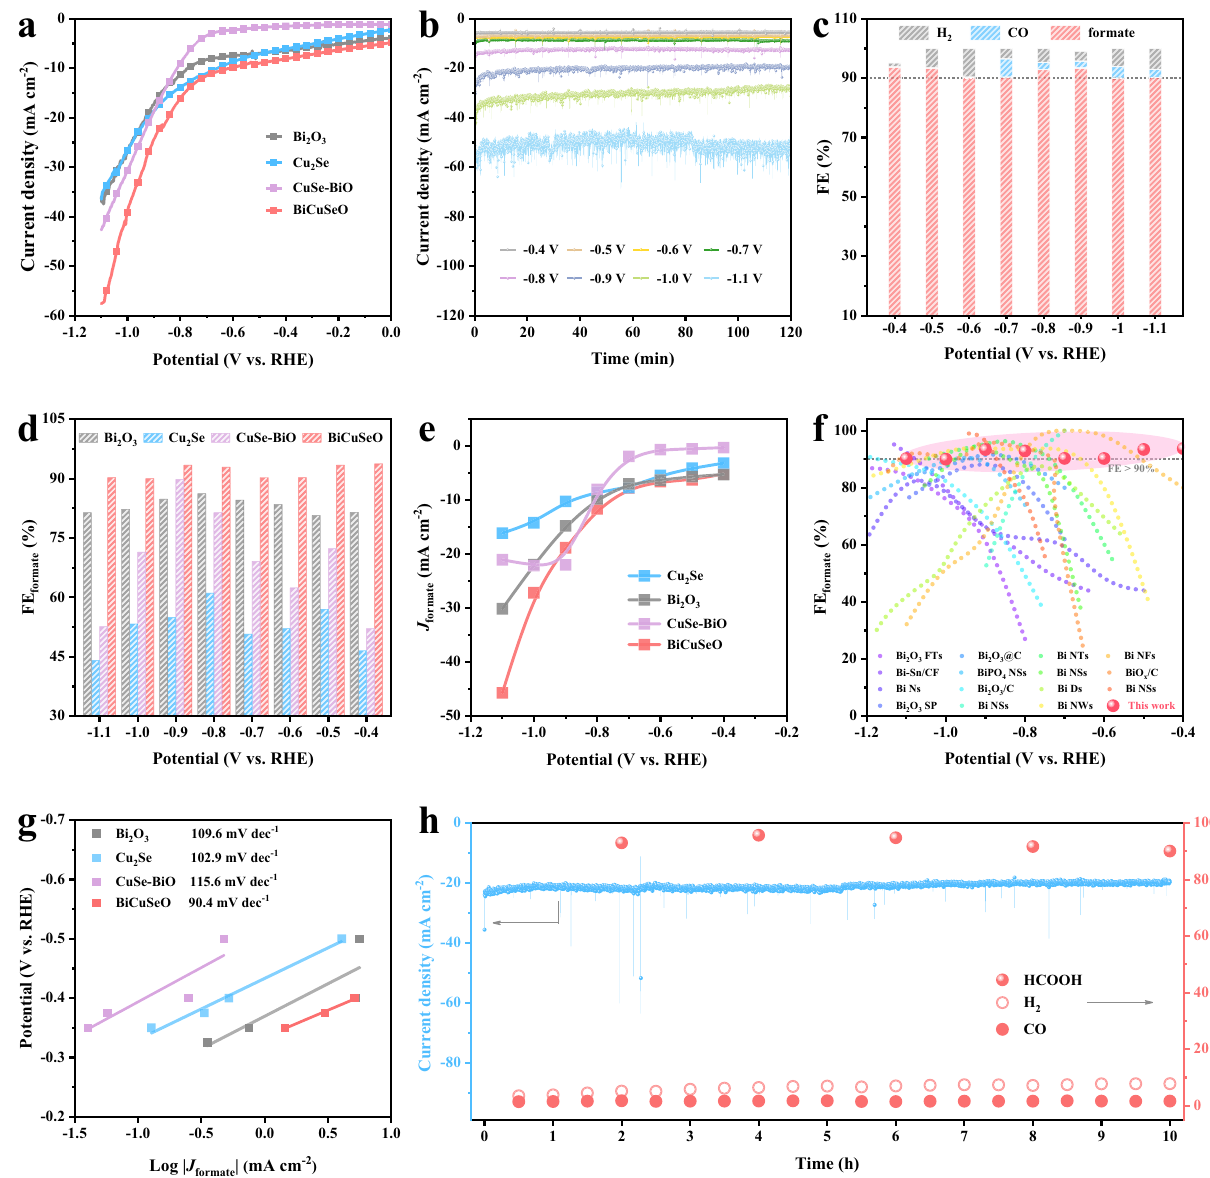
Fig. 2 CO 2 RR performance in 0.5 M KHCO 3 . a LSV curves of BiCuSeO, Cu 2 Se, Bi 2 O 3 Ns, and CuSe-BiO without iR compensation. b Chronoamperometric curves at different potentials. c FE of formate, CO and H 2 for BiCuSeO Ns. d FE formate , e J formate , and g Tafel slope comparisons of BiCuSeO, Cu 2 Se, Bi 2 O 3 Ns, and CuSe-BiO. f FE formate comparison among the reported Bi-based catalysts and the BiCuSeO 10, 26, 27, 32 – 43 . h 10 h Chronoamperometry results for BiCuSeO at − 0.9